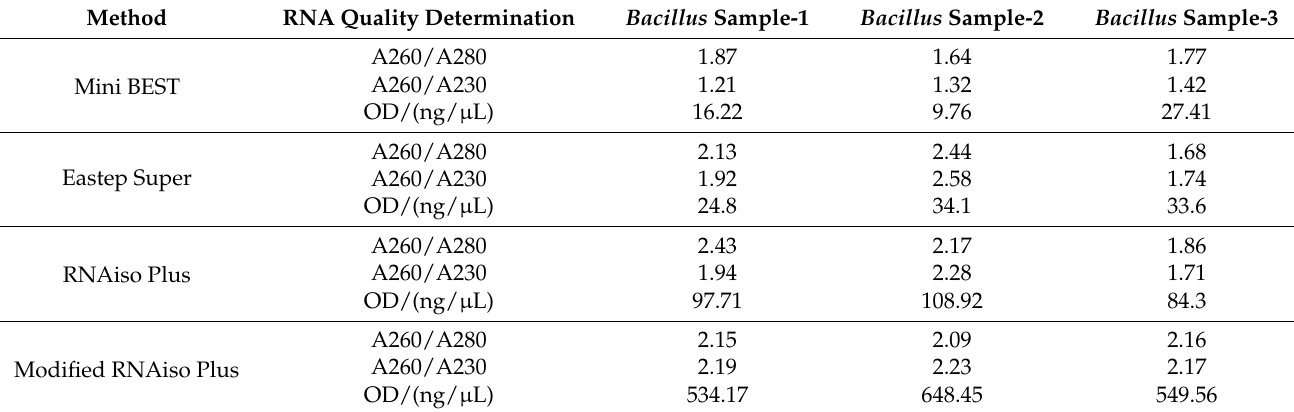
The genomic DNA of Bacillus strains N67, YN1282-2, WBN06, HN04 and G9R-3 was amplified respectively by PCR using 13 pairs of published primers which target thirteen biocontrol marker genes of the Bacillus group. “+” represents the positive result of PCR, “ − “represents the negative result of PCR. 3.4. An Improved RNAiso Plus Method Suitable for Extraction of Total RNA from Bacillus Strains Three kits were used to extract the total RNA of the Bacillus strains and the concentra- tion and purity of RNA were tested by nanophotometer. The general criteria for assessing RNA purity were the proportions of A260/A280 and A260/A230, which were within the range of 2.00 ± 0.10 and 2.00–2.40, respectively. If the proportion of A260/A280 is less than 2.00, it indicates that protein contamination existes in the RNA sample. If the proportion of A260/A230 is less than 2.00, the samples contain the remaining guanidine isothiocyanate and β -mercaptoethanol from the kit reagent. However, the results show that three kinds of RNA extraction kits could not be effective in extraction of high concentrations and qualified total RNA from Bacillus , as shown in Table 3. The quality of RNA extracted by the three kits were beyond the standard range required for evaluating the RNA purity, where the proportion of A260/A280 and A260/A230 of most samples were less than 2.00, indicating contaminating proteins, polysaccharides and phenols in the samples. Moreover, the concentrations of RNA extracted by the three kits were generally very low, and only the RNAiso Plus method could extract RNA with a higher concentration than the other two kits. In summary, for tested Bacillus strains, the extraction of total RNA, none of above three kits provided an adequate protocol (Table 4). Table 4. Comparison of the quality and yield of total Bacillus RNA extracted by the different kits and the modified protocol.